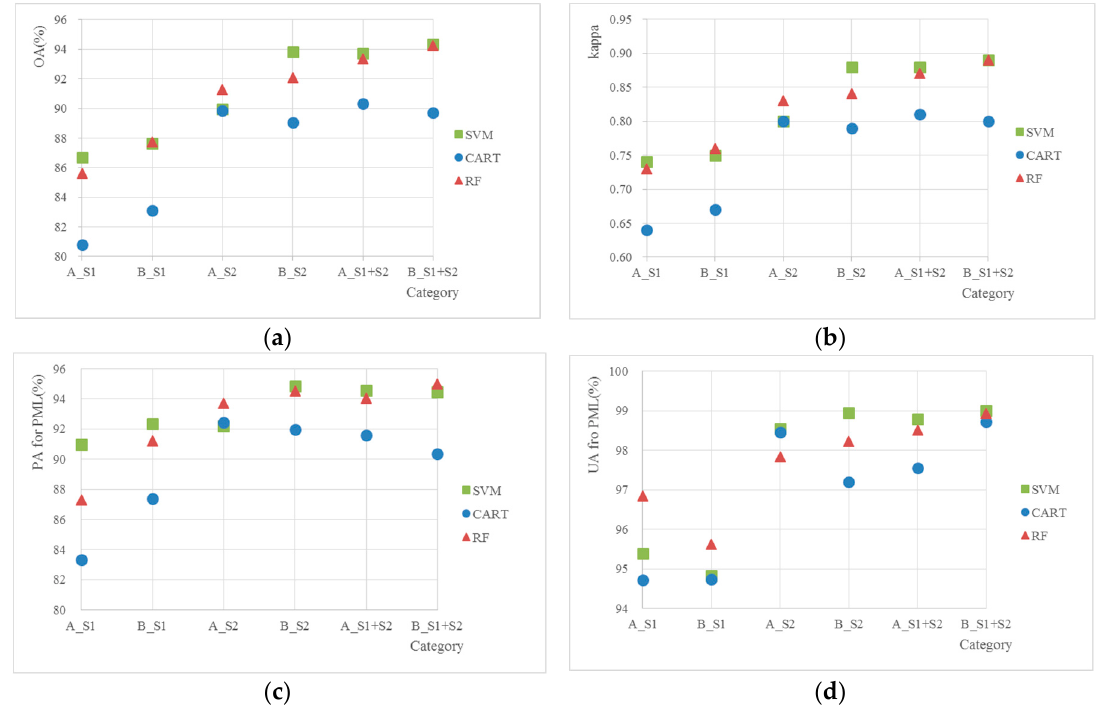
Figure 7. Accuracy assessment for different band combinations and feature selections on three machine learning algorithms: ( a ) Overall accuracy, ( b ) Kappa coefficient, ( c ) Producer’s accuracy for Plastic-Mulched Landcover (PML), and ( d ) User’s accuracy for PML. In the category, A_S1 means using spectral features on Sentinel-1, B_S1 means using spectral and textural features on Sentinel-1. A_S2 means using spectral and index features on Sentinel-2. B_S2 means using spectral, index, and textural features on Sentinel-2; A_S1+S2 means using spectral and index features on Sentinel-1 and Sentinel-2. B_S1+S2 means using spectral, index and textural features on Sentinel-1 and Sentinel-2.